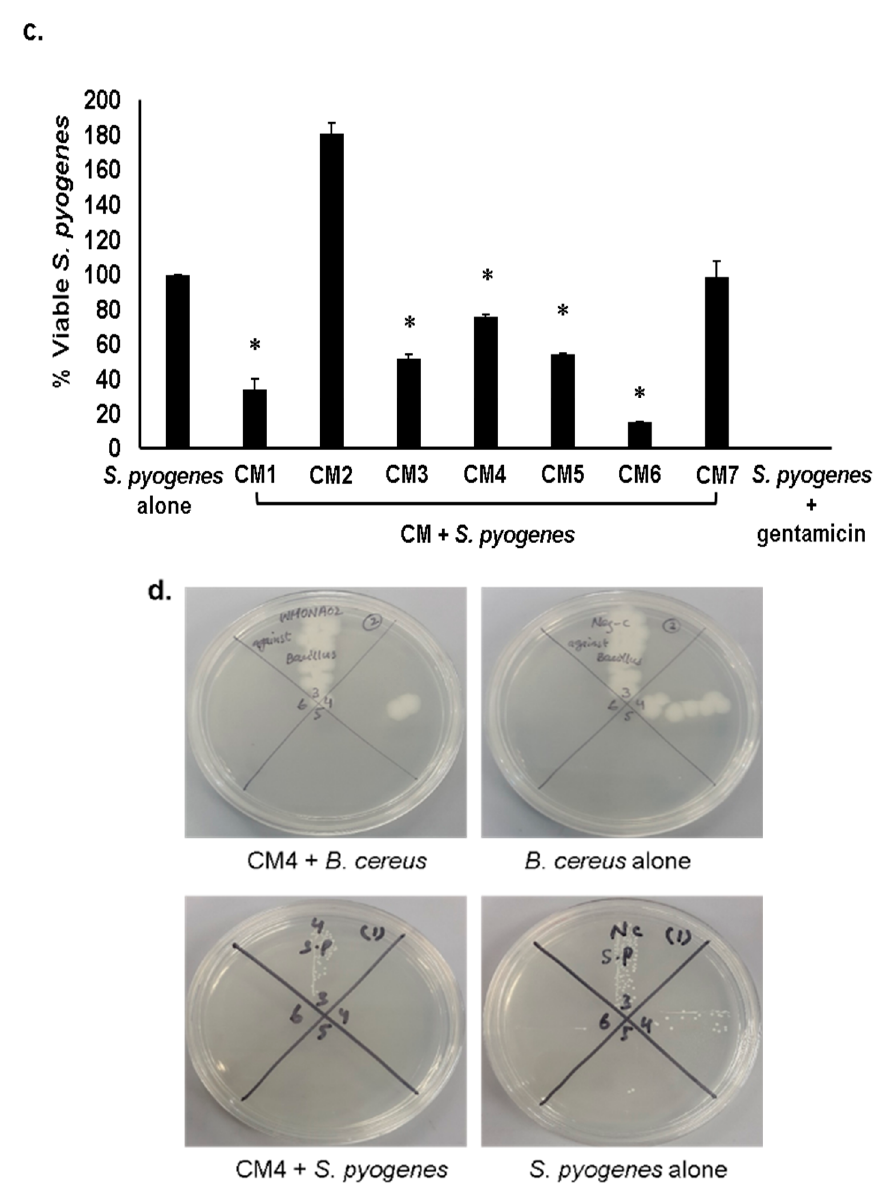
Figure 1. Conditioned medium (CM) from water monitor lizard (WML) gut bacteria exhibited significant bactericidal activities against selected Gram-positive pathogenic bacteria. Briefly, 1 × 10 6 bacteria were mixed with CM from WML gut bacteria and culture was incubated at 37°C for 2 h. Next, the culture was serially diluted and plated on nutrient agar plates. Plates were incubated at 37°C for 24 h and bacterial colonies were enumerated. The data is expressed as the mean ± standard error of several independent experiments performed in duplicate. P values were determined using student’s T -test, two-tailed distribution, (*) is P ≤ 0.05. Bacteria incubated with phosphate-buffered saline (PBS) and gentamicin (100 µg/mL) were taken as negative and positive controls. ( a ) CM tested against B. cereus , ( b ) against MRSA ( c ) against S. pyogenes and ( d ) representative effects of CM against B. cereus and S. pyogenes . CM1 is Proteus mirabilis , CM2 is Aeromonas hydrophila , CM3 is Citrobacter freundii , CM4 is E. coli , CM5 is Staphylococcus sp., CM6 is Staphylococcus aureus and CM7 is E. coli K-12.